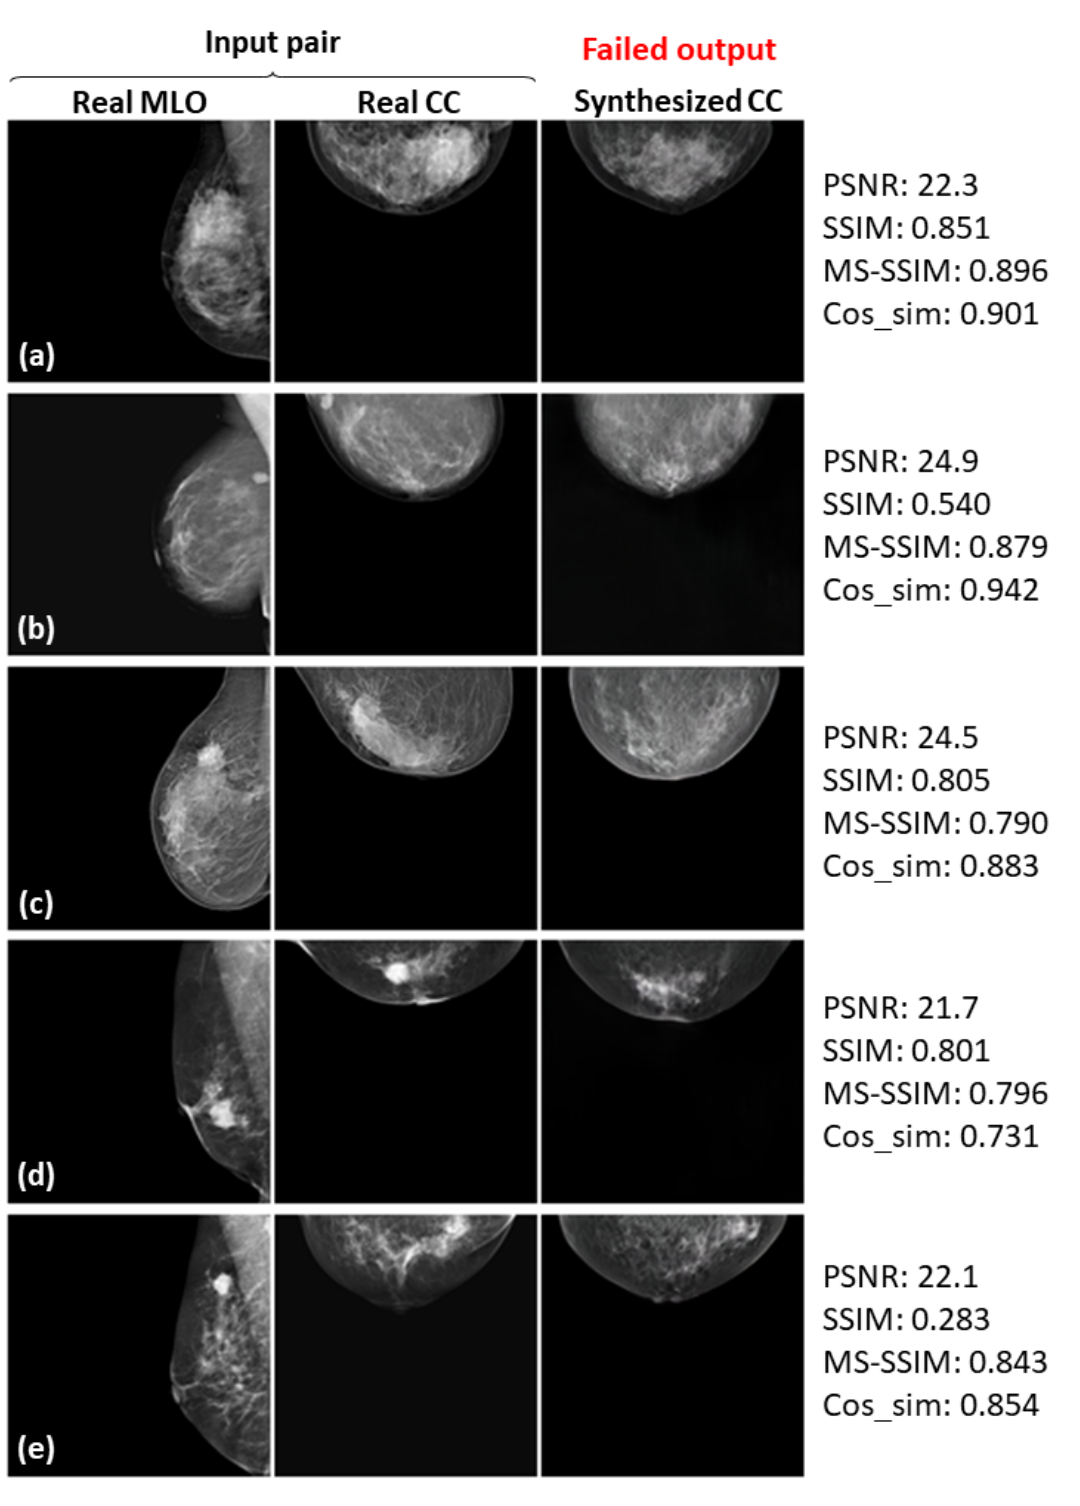
Figure 11. Five failed examples ( a – e ) of the real input paired and synthesized CC-view mammograms at 128 × 128 resolution by bi-directional training of CR-GAN incorporating PG technique and feature matching